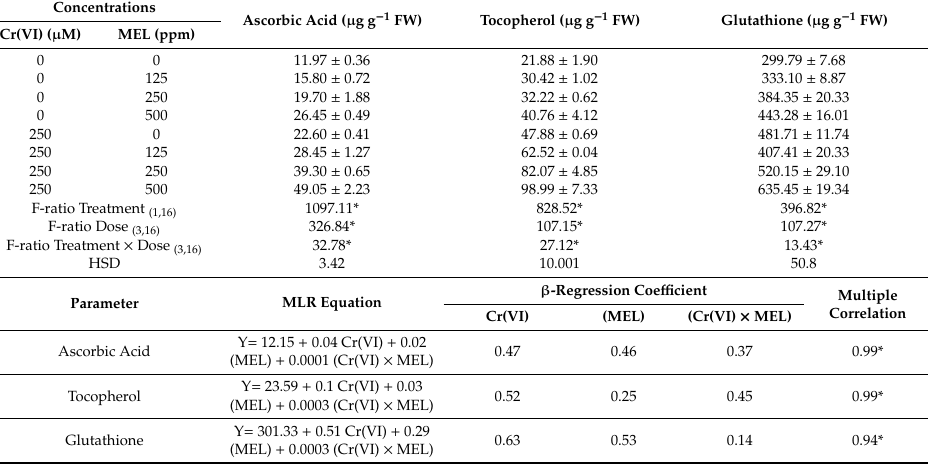
Table 6. E ff ect of Cr(VI), di ff erent concentrations of methanol extract of Rhododendron arboreum leaves (MEL), and their combinations on ascorbic acid, tocopherol, and glutathione content in 7-day-old Vigna radiata seedlings. The values are the means of three replicates ± SD. (standard deviation). Tukeys test performed and significance checked at * p ≤ 0.05. The F ratio is the term in which ANOVA is represented; Cr(VI) = Dose, MEL treatments = Treatment and combination of Cr(VI) and MEL = Dose × treatment.